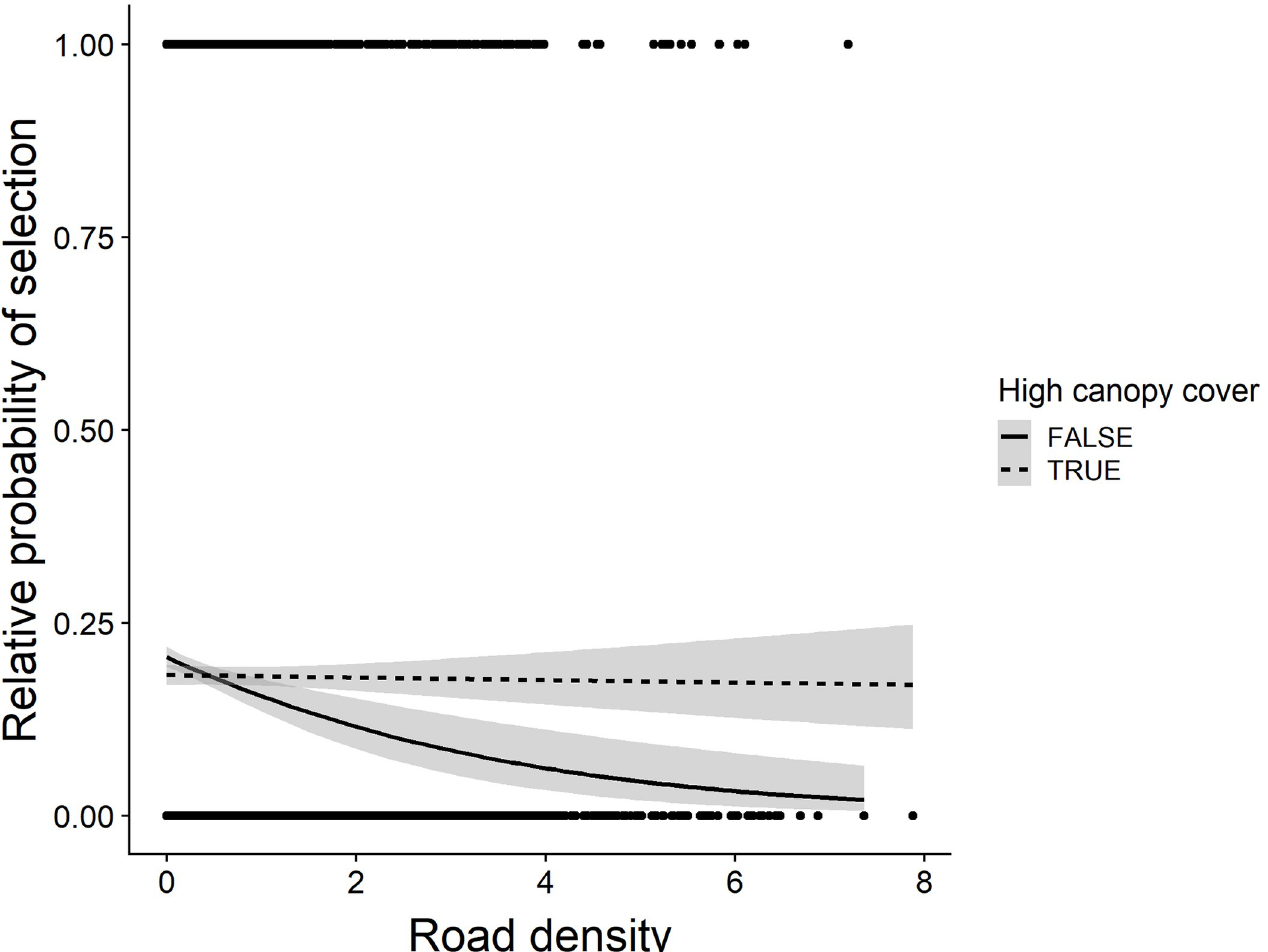
Fig 2. Selection for road density in high versus low canopy cover by wolves on the Rocky Mountain Front. Relative probability of selection for roads in high canopy cover ( > 35%, dashed line) versus low canopy cover ( < 35%, solid line) areas by wolves on the Rocky Mountain Front, MT, USA. This cutoff was calculated as the median value of canopy cover at available